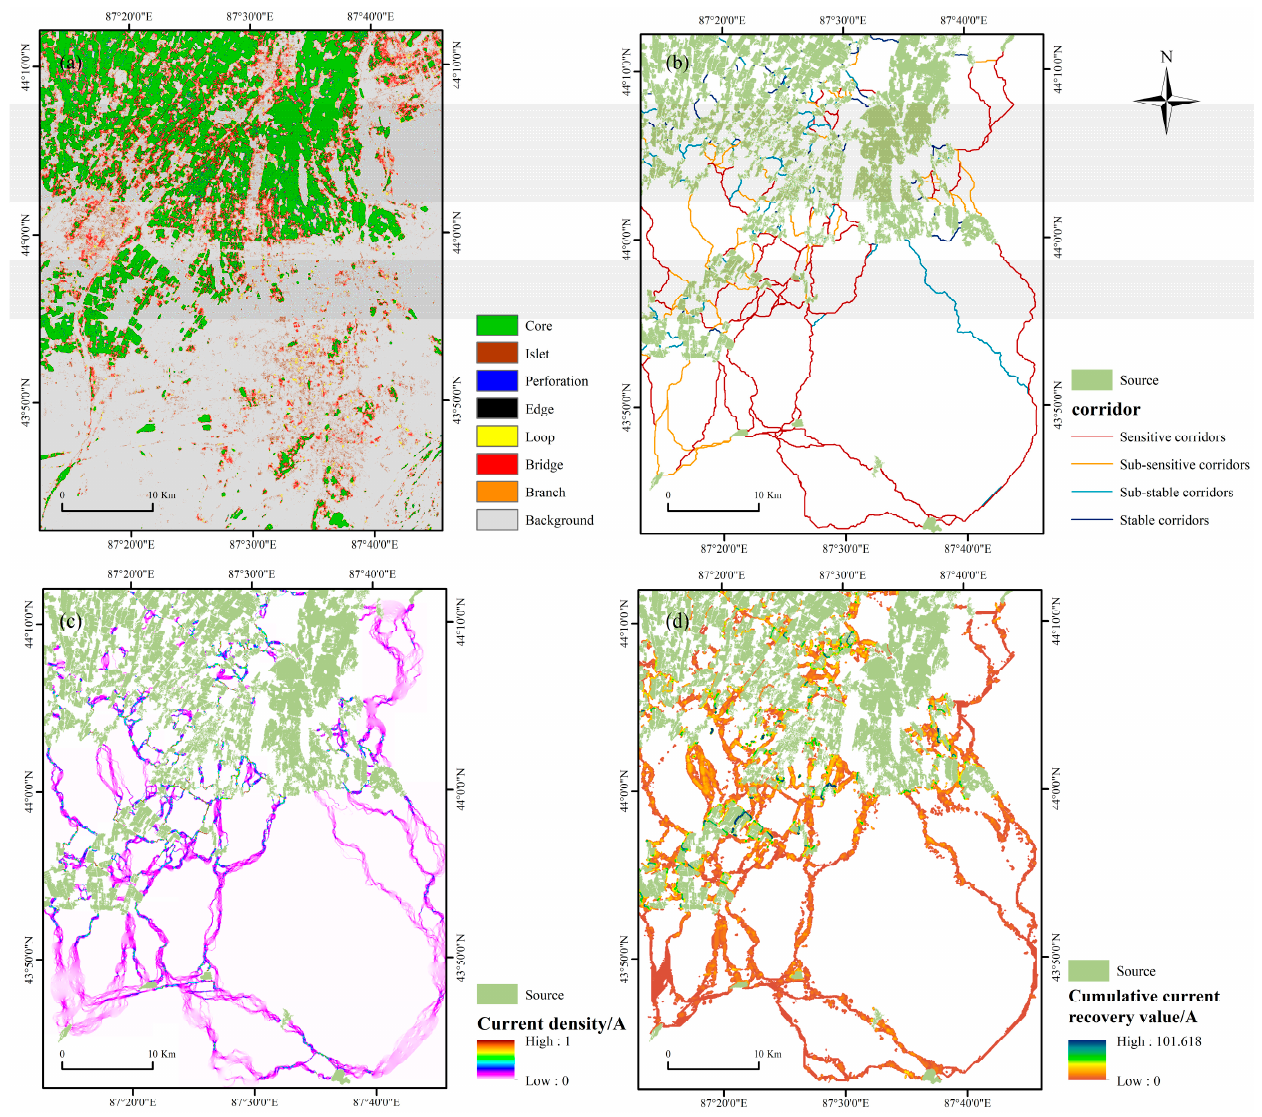
Figure 10. Green corridor, pinch point, and obstacle point identification for the thermal environment based on MSPA and circuit theory: ( a ) cold island patch classification based on MSPA; ( b ) green corridor identification and importance classification; ( c ) key pinch point identification; ( d ) key obstacle point identification.